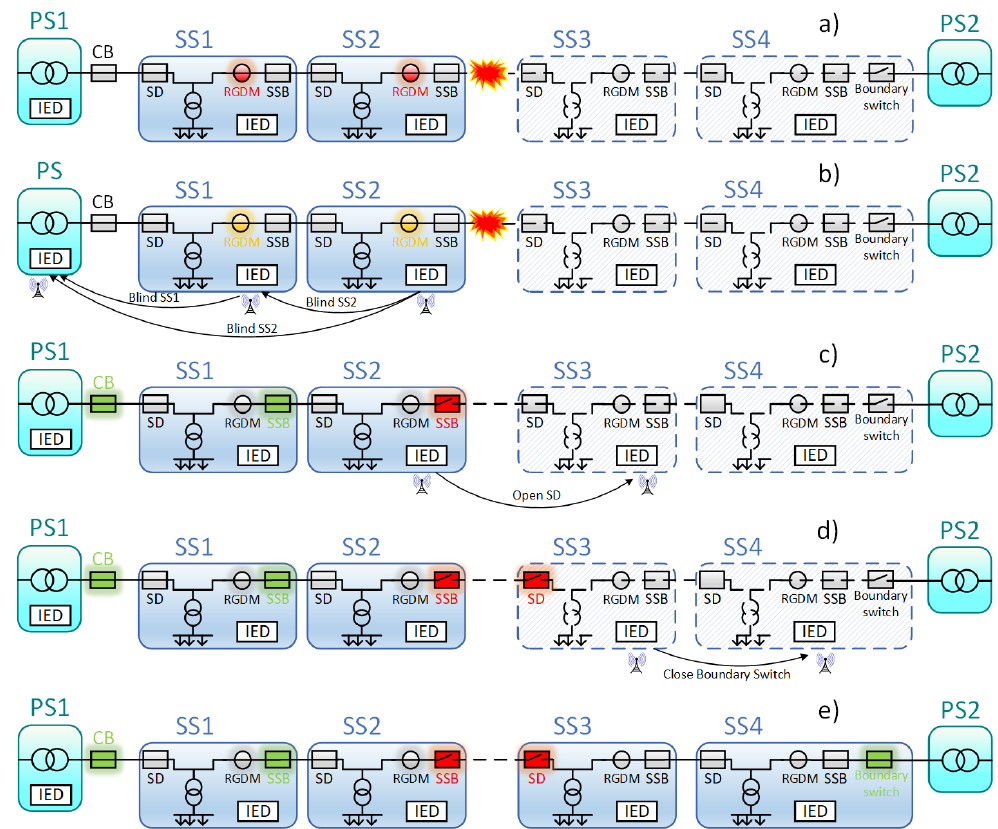
Figure 3. SFS automation steps with re-powering from a downstream PS; ( a ) fault occurrence and detection by RGDMs, ( b ) blind messages are sent upstream to prevent CB and SSB opening, ( c ) since it does not receive the blind message, SS2 opens its SSB and sends downstream a message to open the SD of the successive substation, ( d ) the substation propagates downstream to the other substations a message to close boundary switch, ( e ) SS3 and SS4 are re-powered by closing the boundary